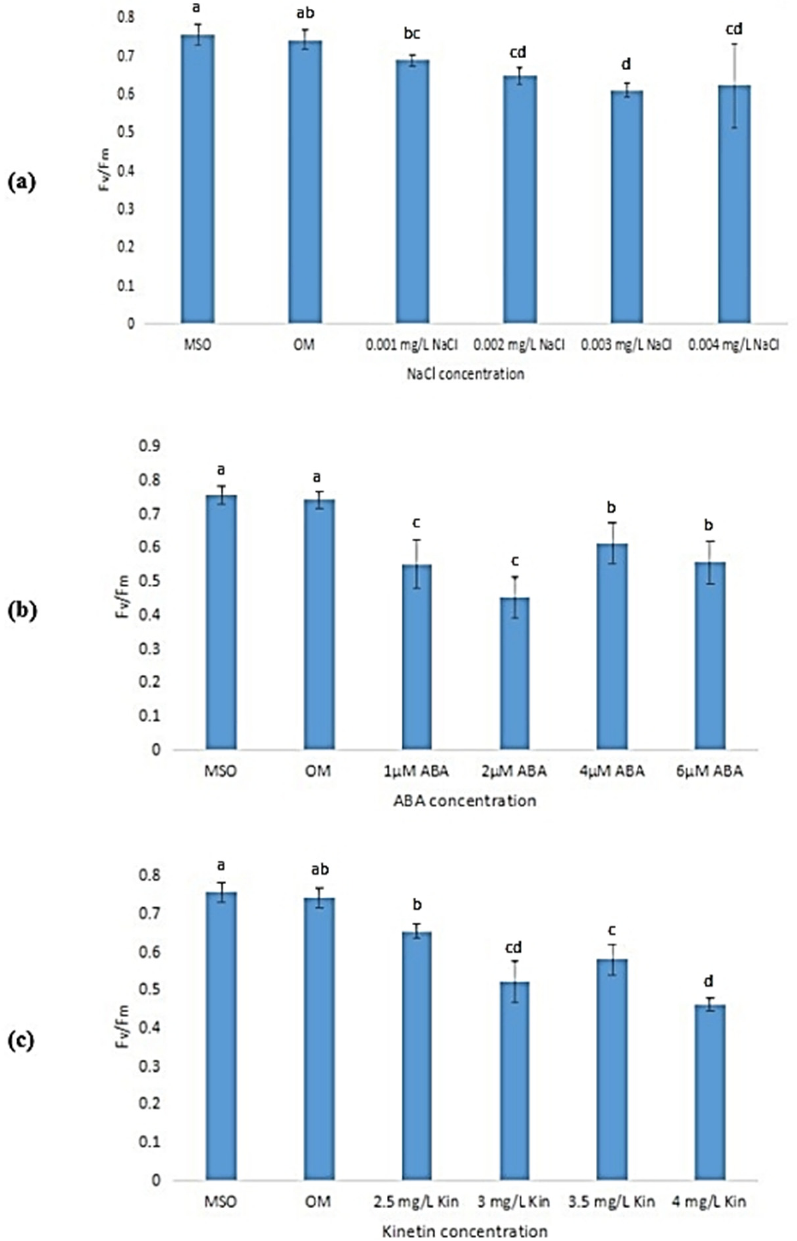
Figure 14. F v /F m of plants exposed to: ( a ) salt stress; ( b ) ABA; ( c ) high kinetin levels. Means with different letters are significantly different at p < 0.05 according to Duncan’s multiple range test (DMRT).